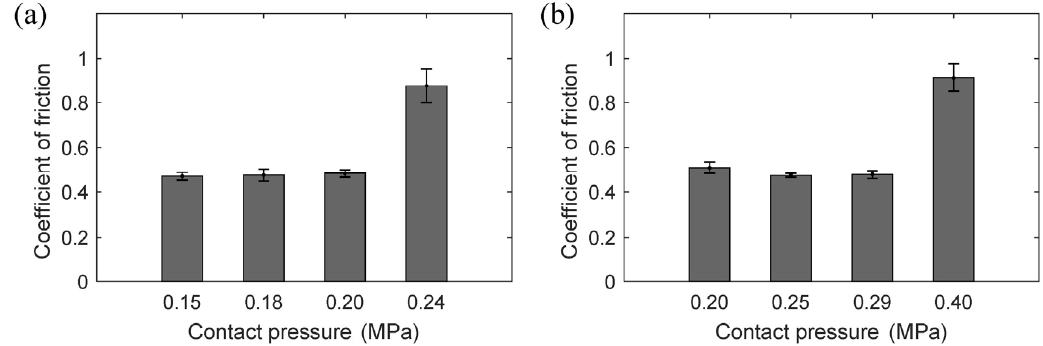
Fig. 9 Steady-state coefficients of friction at various contact pressures: (a) composite 15 SF and (b) composite 15